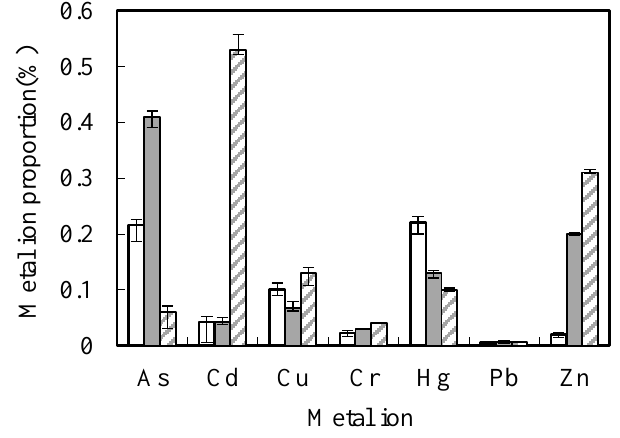
Figure 4. Heavy metals bring-in proportions account for total volume in soil. %.